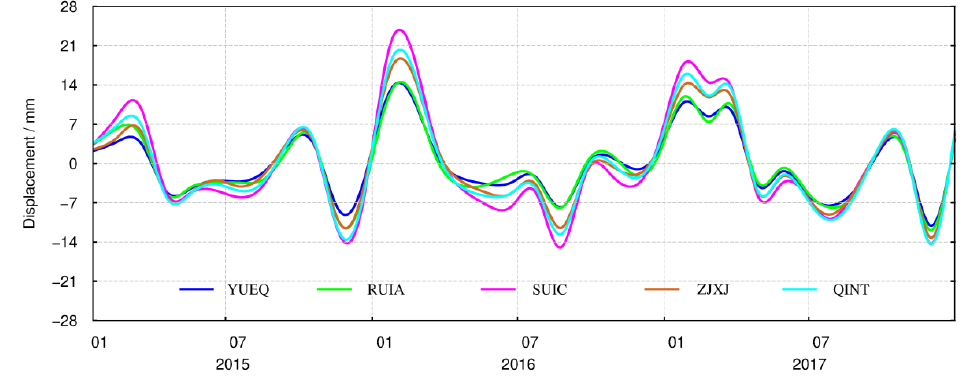
Figure 6. Time series of the crustal vertical deformation caused by groundwater loading at the CORS.